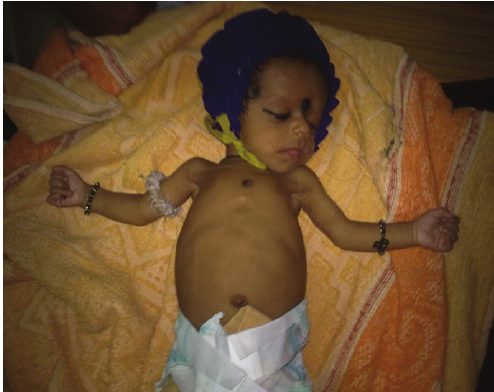
Figure 6: Posttreatment picture showing